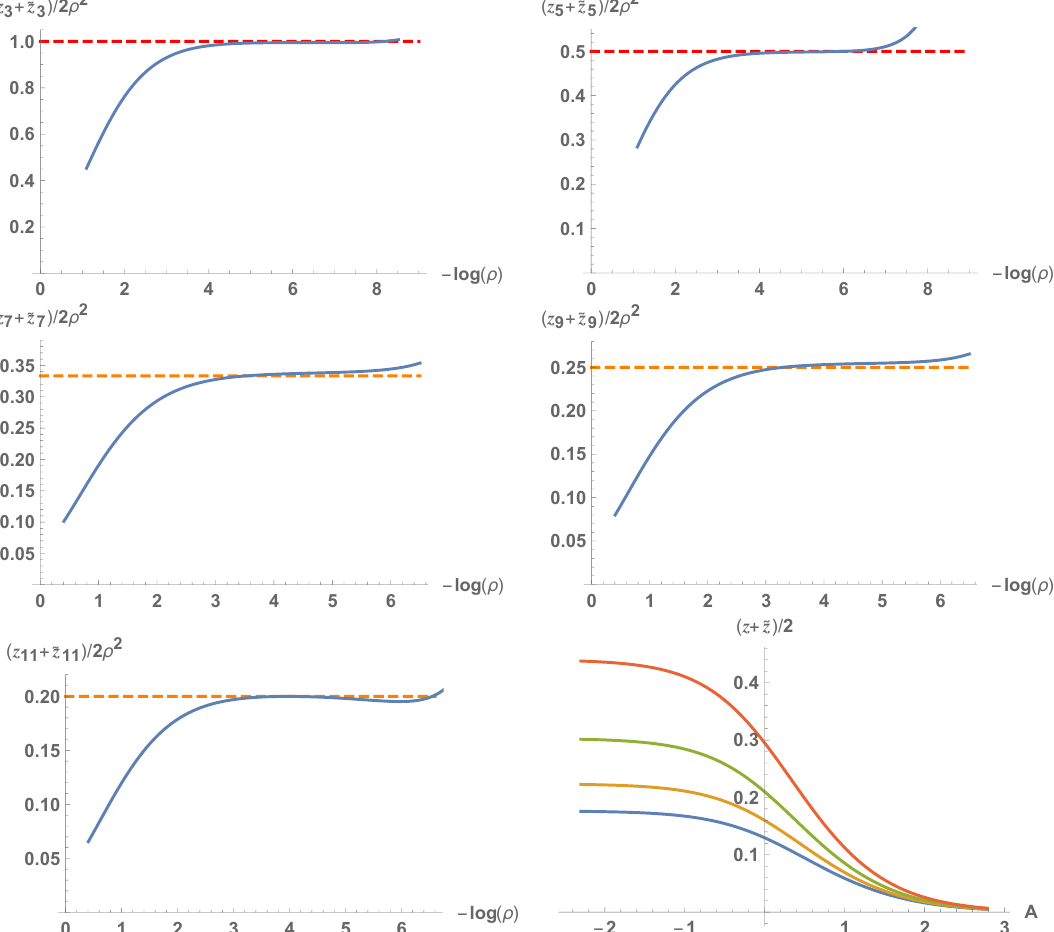
Figure 2 . Graphs of the BPS solutions based on our perturbative analysis. From the top-left one to the down-left one, we illustrate how our perturbative solution via series expansion agrees with the prediction v 2 k +1 = 1 =k for k (cid:21) 1. The horizontal axis in these plots represent log(1 =(cid:26) ), and the vertical axis denotes ( z 2 k +1 +~ z 2 k +1 ) , where (cid:26) = (1 (cid:0) r ) = (1 + r ). Because the series expansion is not 2 (cid:26) 2 analytic at r = 1, the desired limits can be extracted at some value of r close to 1. The bottom-right plot shows ( z + ~ z ) = 2 as function of warp factor A , for several representative values of (cid:15) . We choose (cid:15) = 0 : 4 ; 0 : 8 ; 1 : 2 ; 1 : 6, and lower (higher) curves correspond to smaller (larger) values of (cid:15)